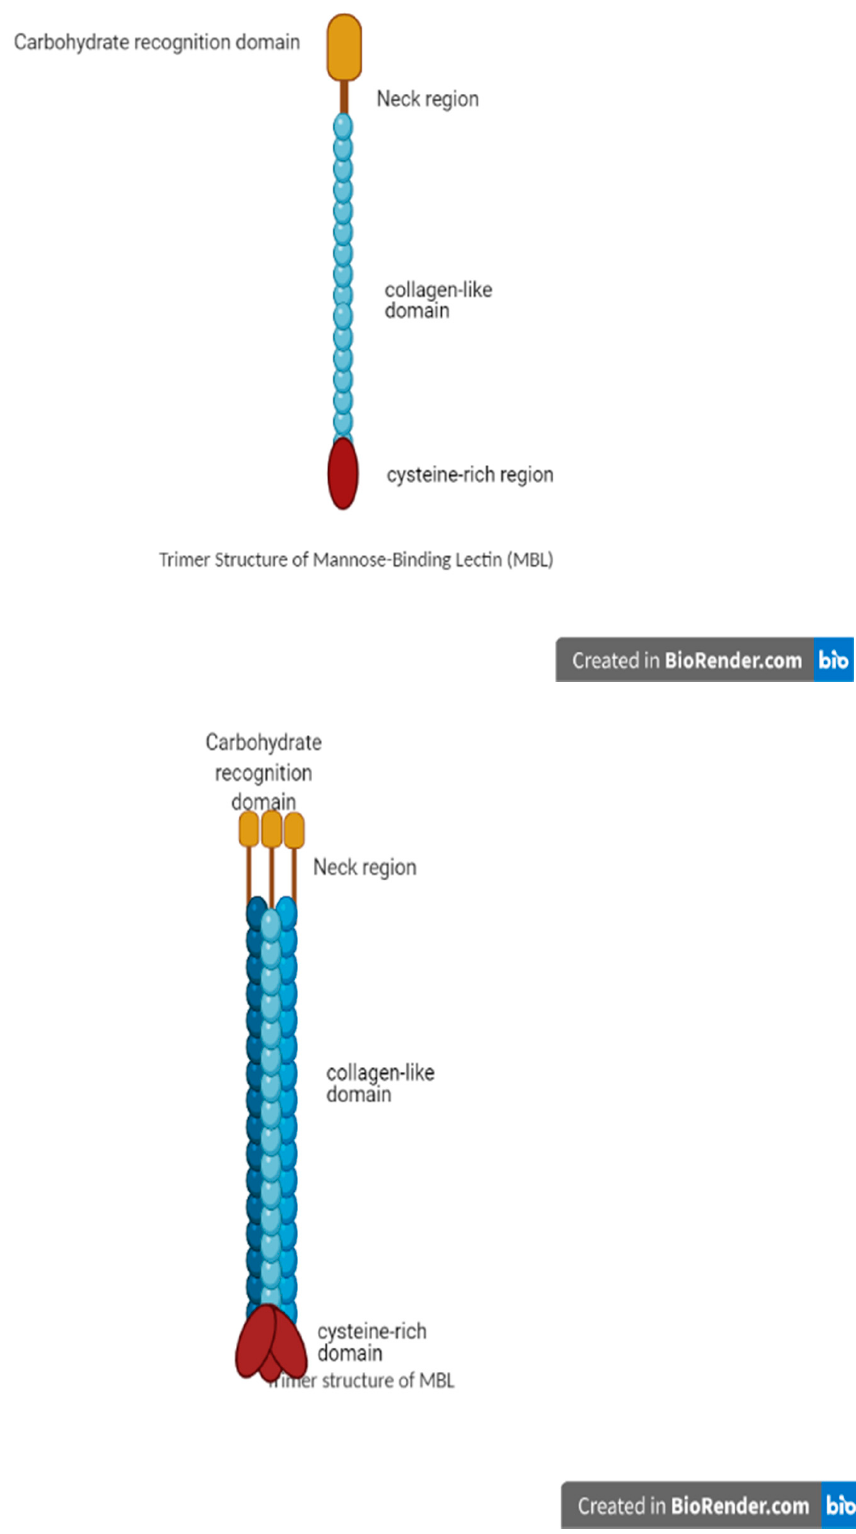
Figure 1. Set of domain of the collagenous MBL (mannose-binding lectin).